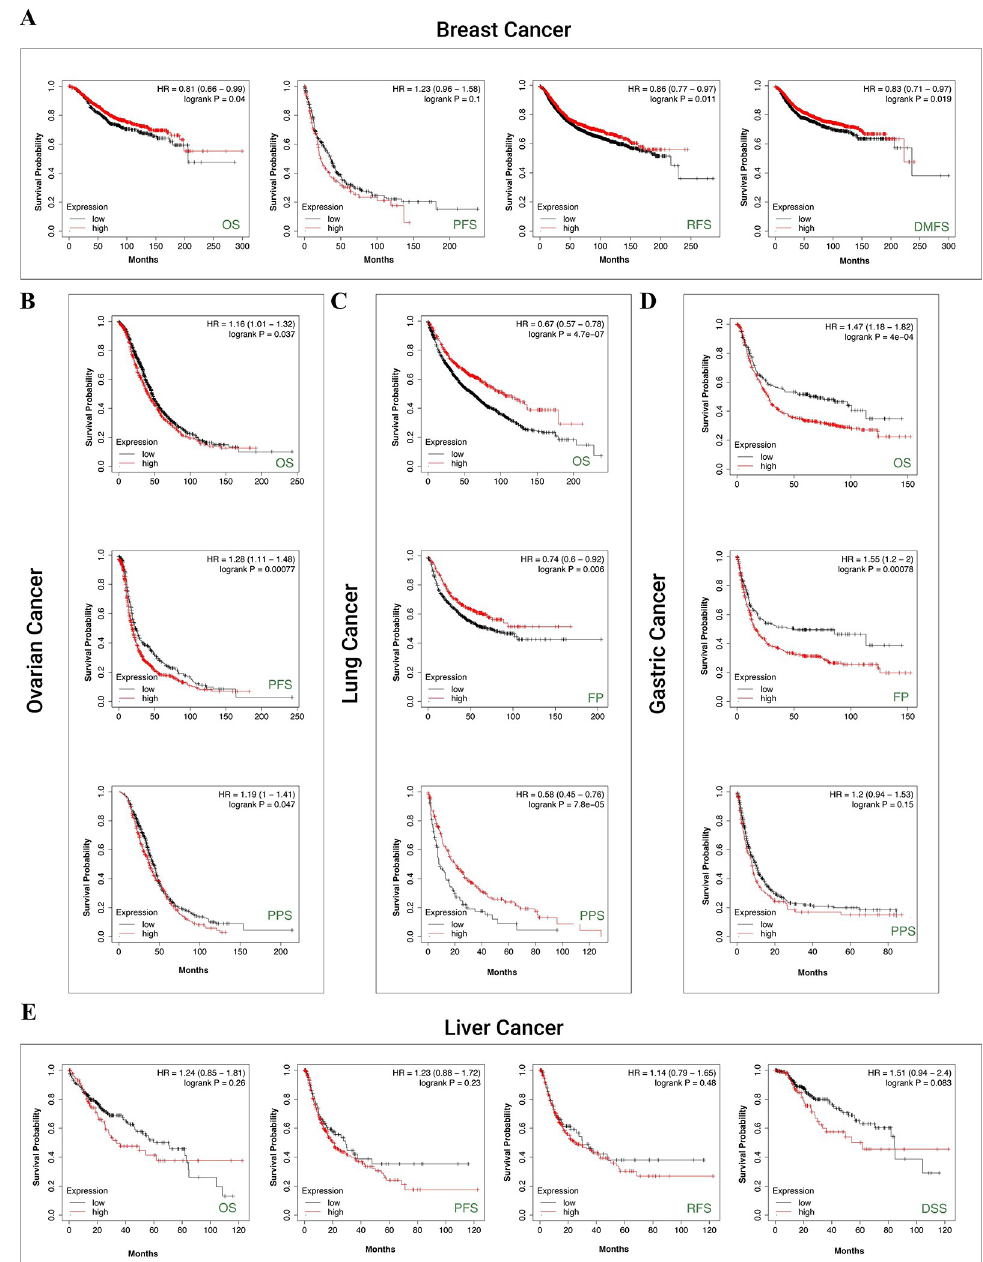
Fig 6. Correlation analysis between SMARCA1 expression and prognosis of different cancers via Kaplan-Meier plotter. (A) OS, PPS, RFS, DMFS in breast cancer; (B) OS, PFS, PPS in ovarian cancer; (C) OS, FP, PPS in lung cancer; (D) OS, FP, PPS in gastric cancer; (E) OS, PFS, RFS, DSS in liver cancer. OS, overall survival; PPS, post progression survival; RFS, relapse free survival; DMFS, distant metastasis free survival; FP, first progression; PFS, progress free survival; DSS, disease-specific